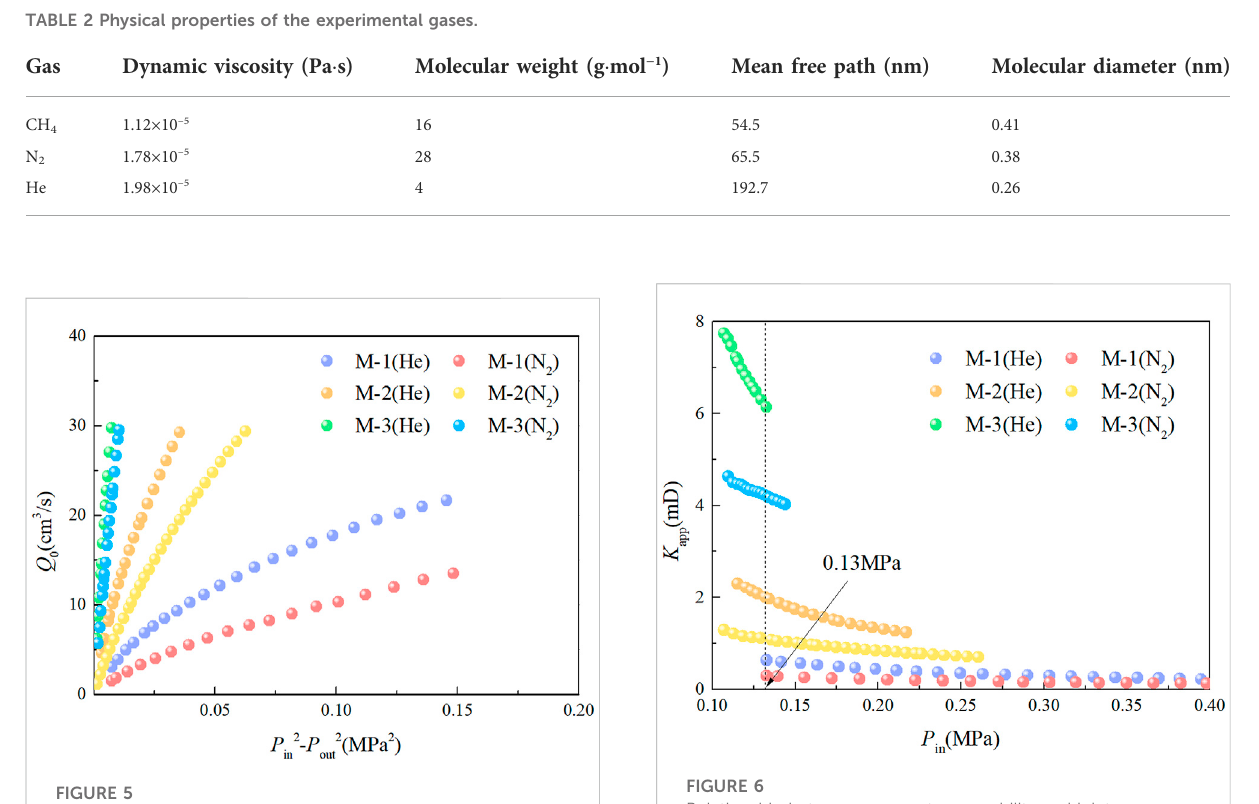
FIGURE 6 Relationship between apparent permeability and inlet